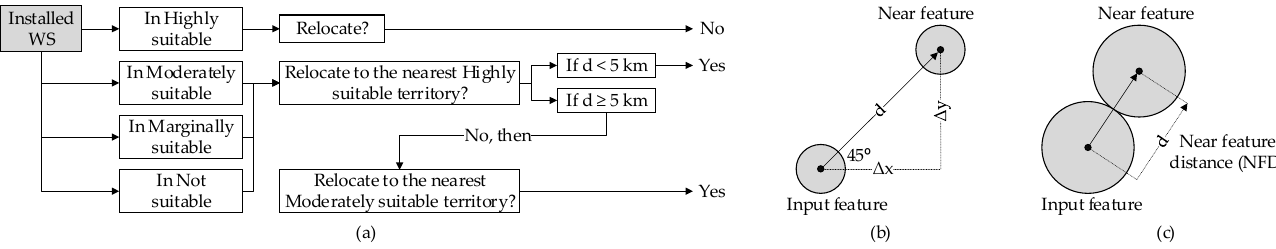
Figure 3. ( a ) Decision rule for the relocation of installed weather stations (WS). The method of near analysis (NA) [54]: ( b ) the distance from input feature to near feature is calculated based on the Pythagorean theorem and the differences in their coordinates, and ( c ) an example of calculating near feature distance for circular symbols when defined as symbol diameter.